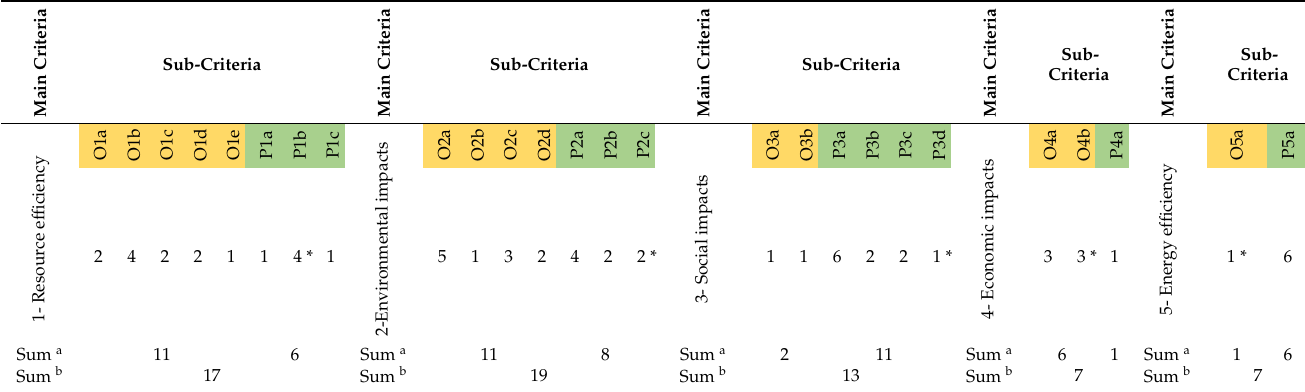
Table 5. The proposed credits for main and